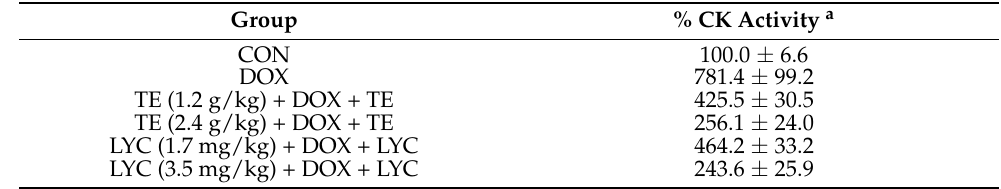
Table 5. Effect of tomato extract (TE) and lycopene (LYC) on DOX-induced CK level changes in mice